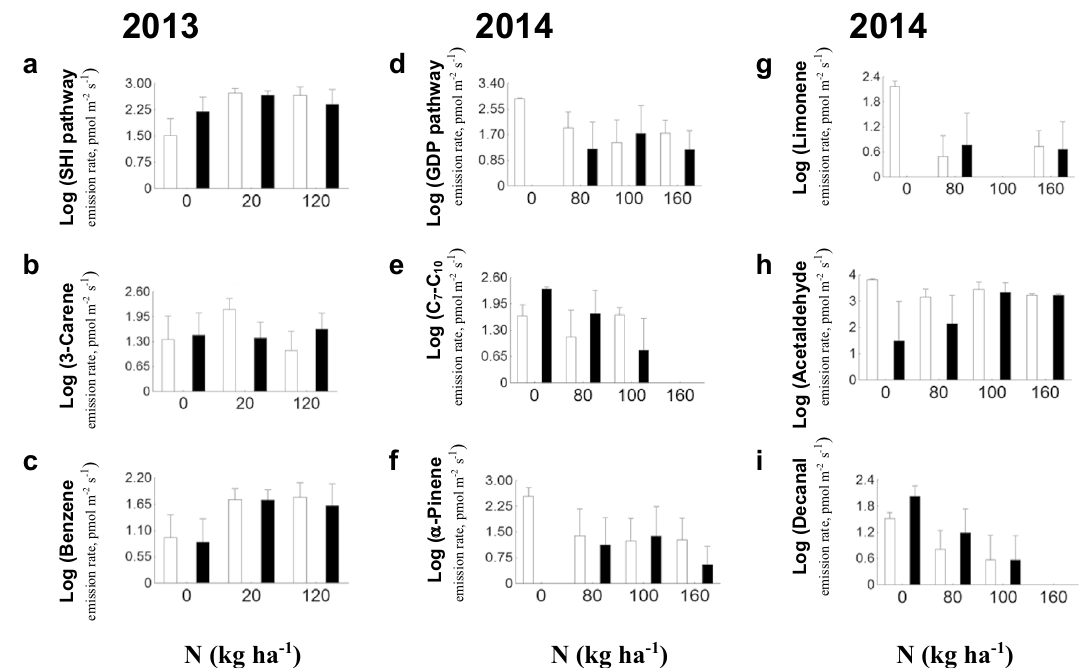
Figure 2. Emission rates (mean + SE) of different VOC formation pathways ( a , d , e ) and individual compounds ( b , c , f , g , h , i ) from Brassica napus plants in 2013 and 2014 in relation to nitrogen fertilization before (white bars) and during pollen beetle infestation (black bars). SHI—shikimate pathway volatiles; GDP—geranyl diphosphate pathway volatiles; C 7 –C 10 —long-chained saturated